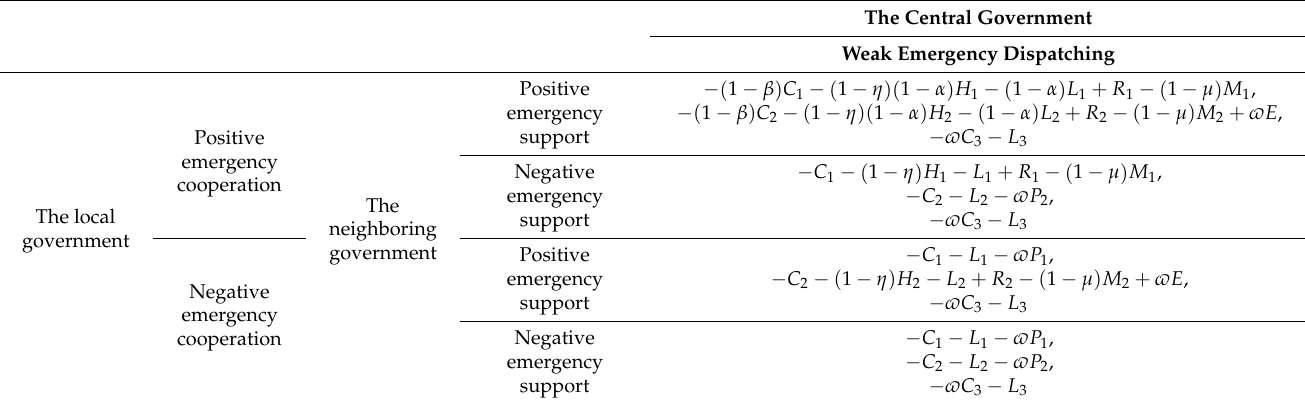
Table 3. The payment matrix under the central government’s weak emergency dispatching